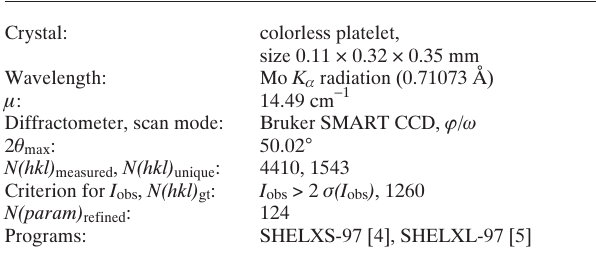
Table 1. Data collection and handling.